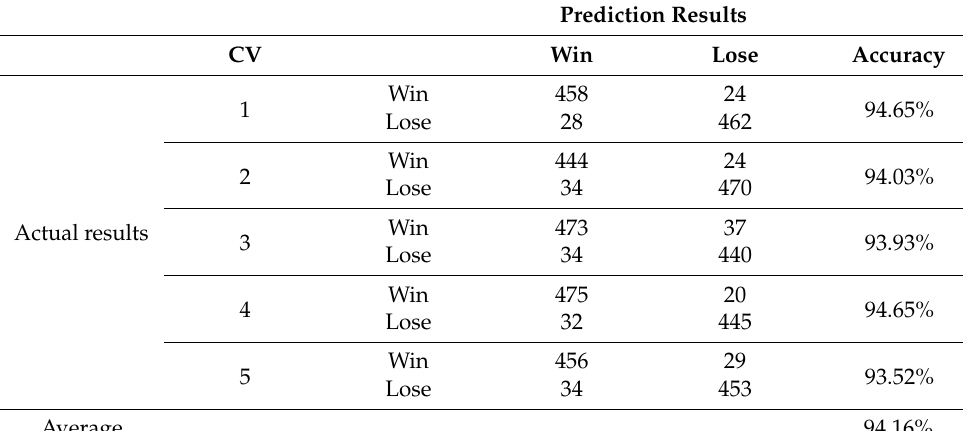
Table 15. Confusion matrix of SVM after feature selection (dataset